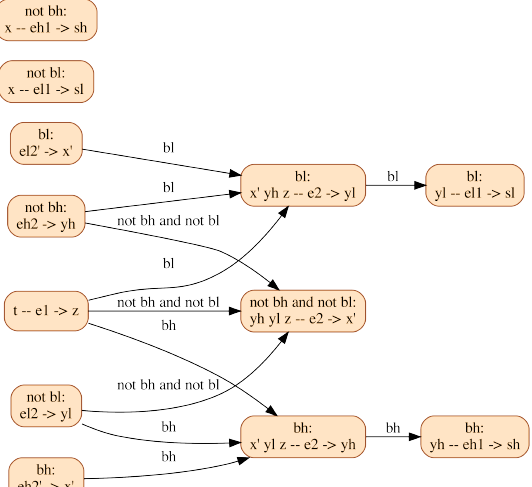
Figure 7. CDG resulting from the multimode structural analysis of the Water Tank model. Vertices are labeled following the same rules as for Figure 2. Edges express causal dependencies, meaning that a block can be solved only after all its predecessors have been solved. They are labeled by Boolean conditions, characterizing the modes in which the dependency